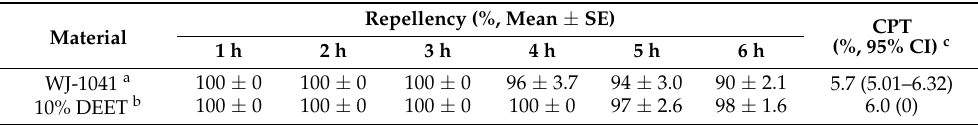
Table 8. Repellency and CPT of WJ-1041 containing 10% veratraldehyde as an active ingredient against Culex pipiens pallens females using the indoor test.